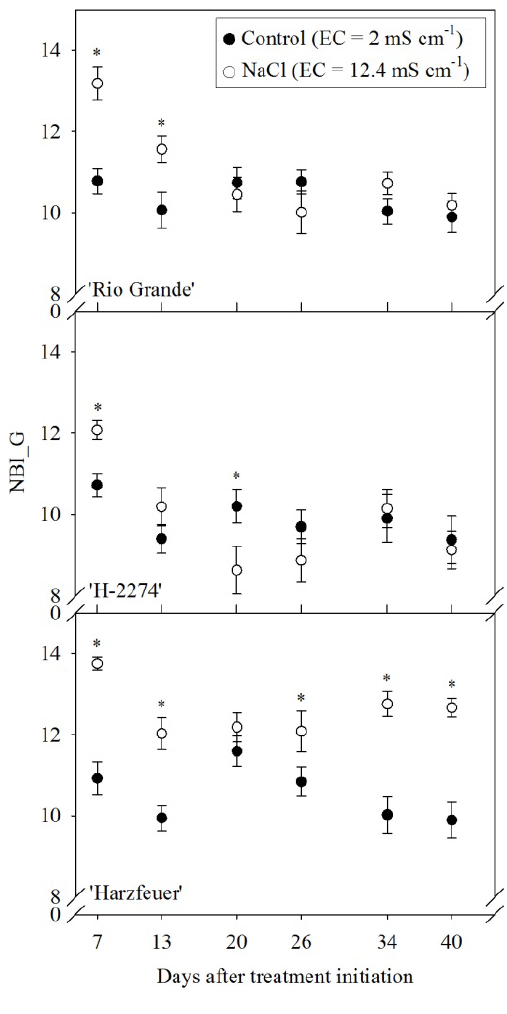
Figure 4. The ratio of UV-excited far-red fluorescence to green-excited red fluorescence (NBI_G). Readings were taken on tomato leaves from “Rio Grande”, “H-2274” and “Harzfeuer”. Values represent the mean ± SE ( n = 10). * Significant differences ( p ≤ 0.05) between control and NaCl treatment for each genotype and measuring day, assessed by t